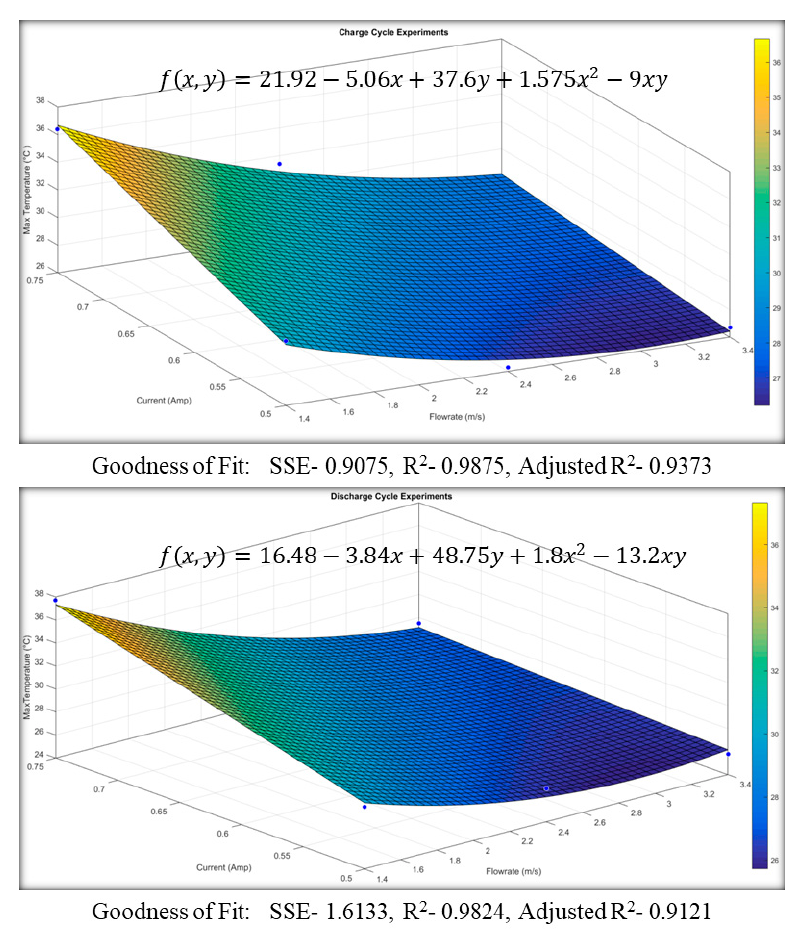
Figure 25. Response surface model (RSM) developed for charge and discharge experiment.